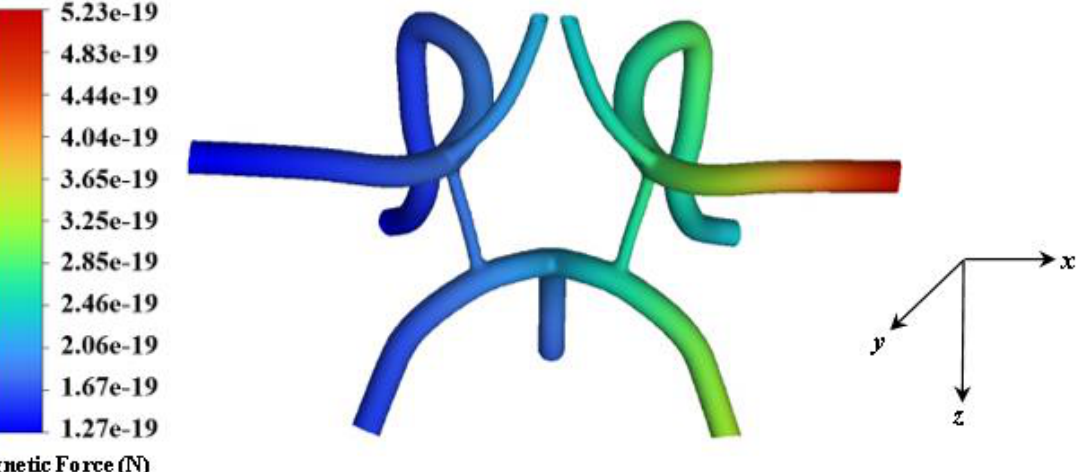
Figure 8. Contour of force magnitudes as a response to the magnetic field strength (at B r = 2.0T) over the entire fluid arterial domain generated in ANSYS Fluent.